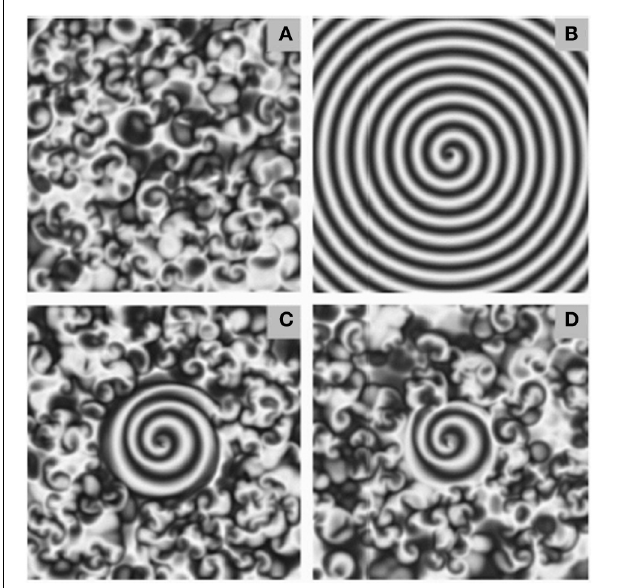
FIGURE 6 | Examples of spiral seeding in a background of chaotic turbulence. Seeding and growing spiral waves in a background of chaotic turbulence. The extent of the spiral wave seeded was dependent on the frequency of periodic forcing at the singularity. Too low, or too high, frequency was less effective. The ratio of the frequency of the forcing signal to that of the angular frequency of the spiral equalled (A) 0.6 (B) 0.8 (C) 1.0 (D) 1.2. Figure reprinted from Zhang et al. (2002). Copyright American Physical Society